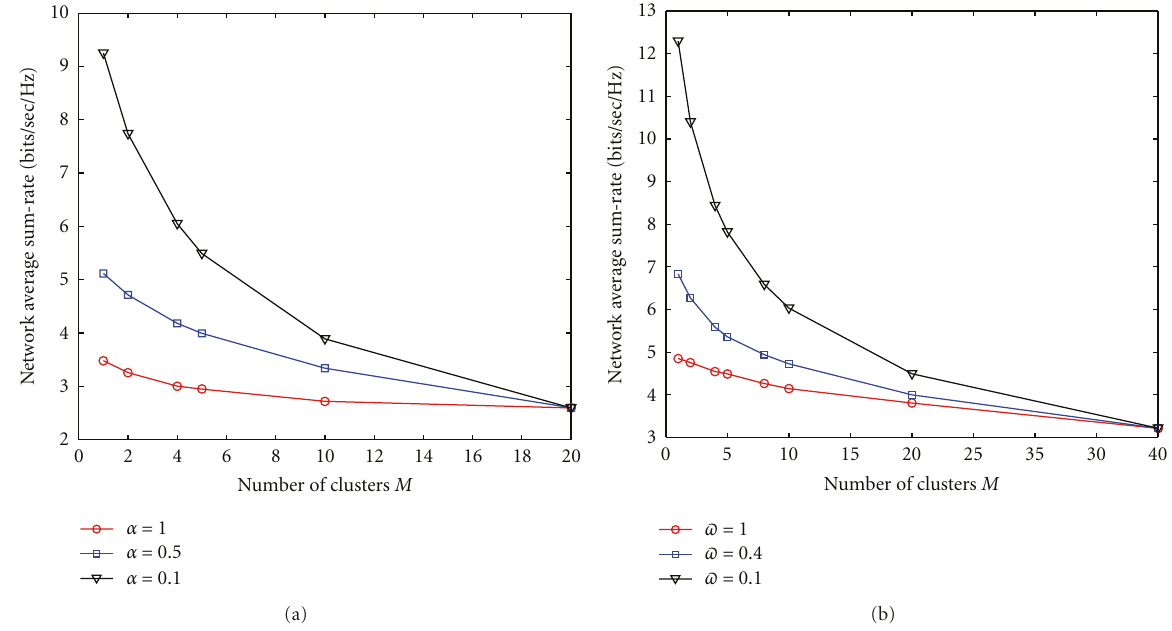
Figure 1: Network average sum-rate versus M for (a) K = 20, α = 1,0 . 5,0 . 1, and shadowing model with (cid:3) = 0 . 5 and variance 1 and for (b) K = 40, α = 0 . 5, and shadowing model with (cid:3) = 1,0 . 4,0 . 1 and variance 1.